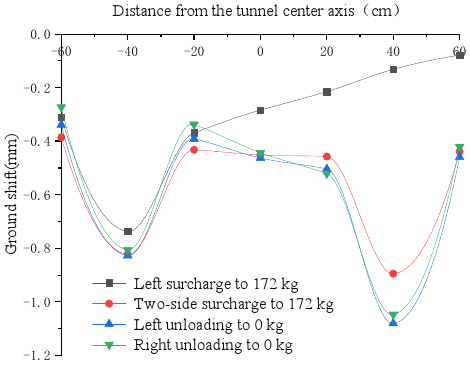
Figure 11. Variation in ground shift under different surcharges for Case 2.